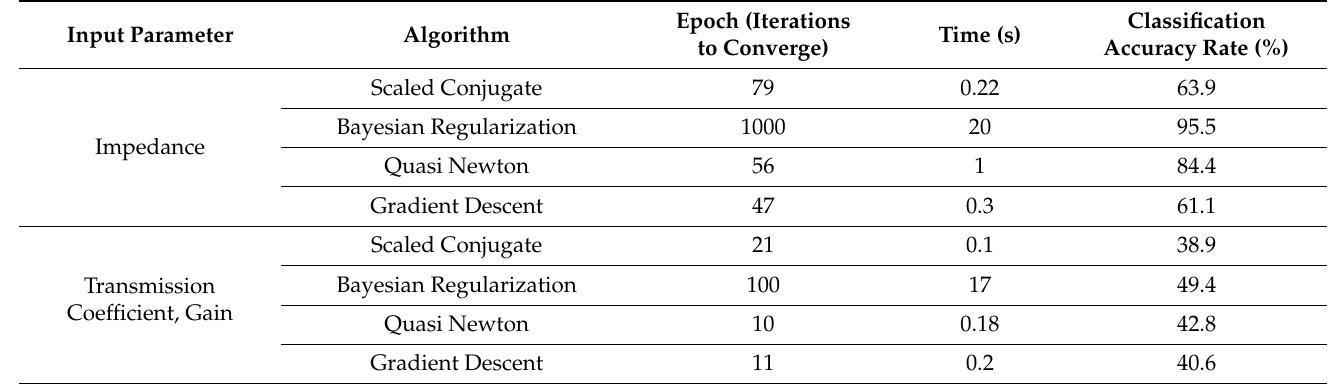
Table 7. Classification Performance between crack